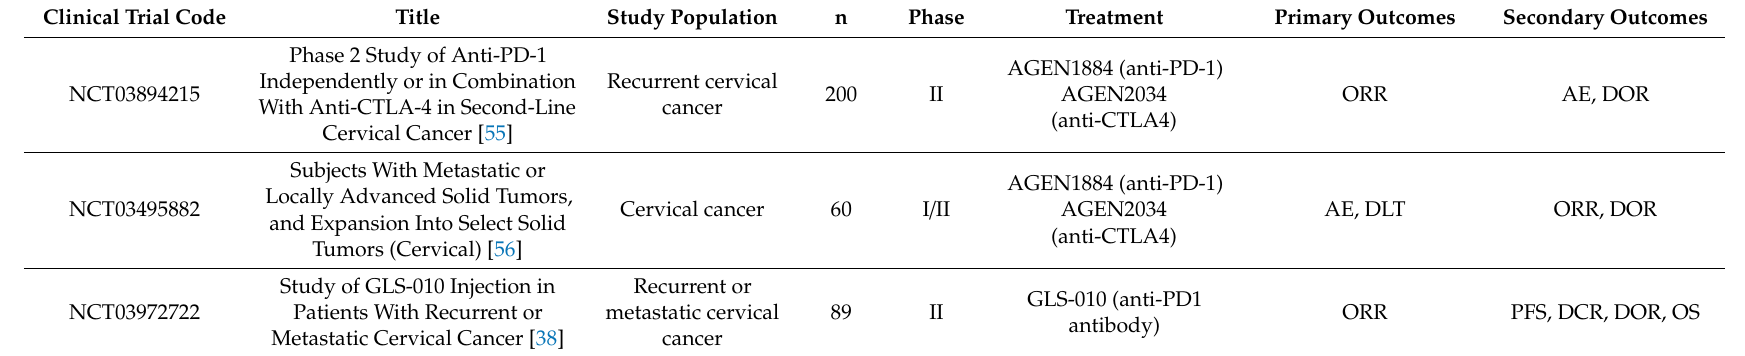
Table 5. Ongoing clinical trials of immunotherapy for cervical cancer (combinations with checkpoint inhibitors).